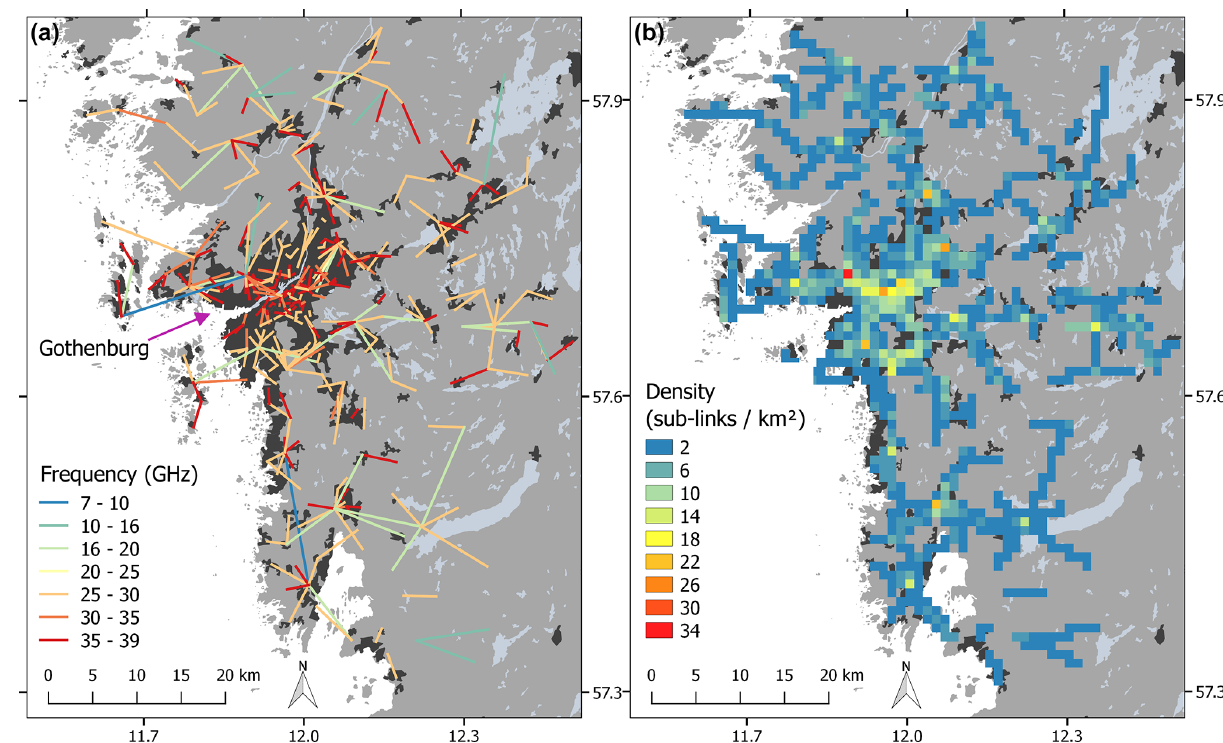
Figure 5. Map of the microwave link network in Gothenburg, Sweden, showing the (a) carrier frequency and (b) sub-link density.